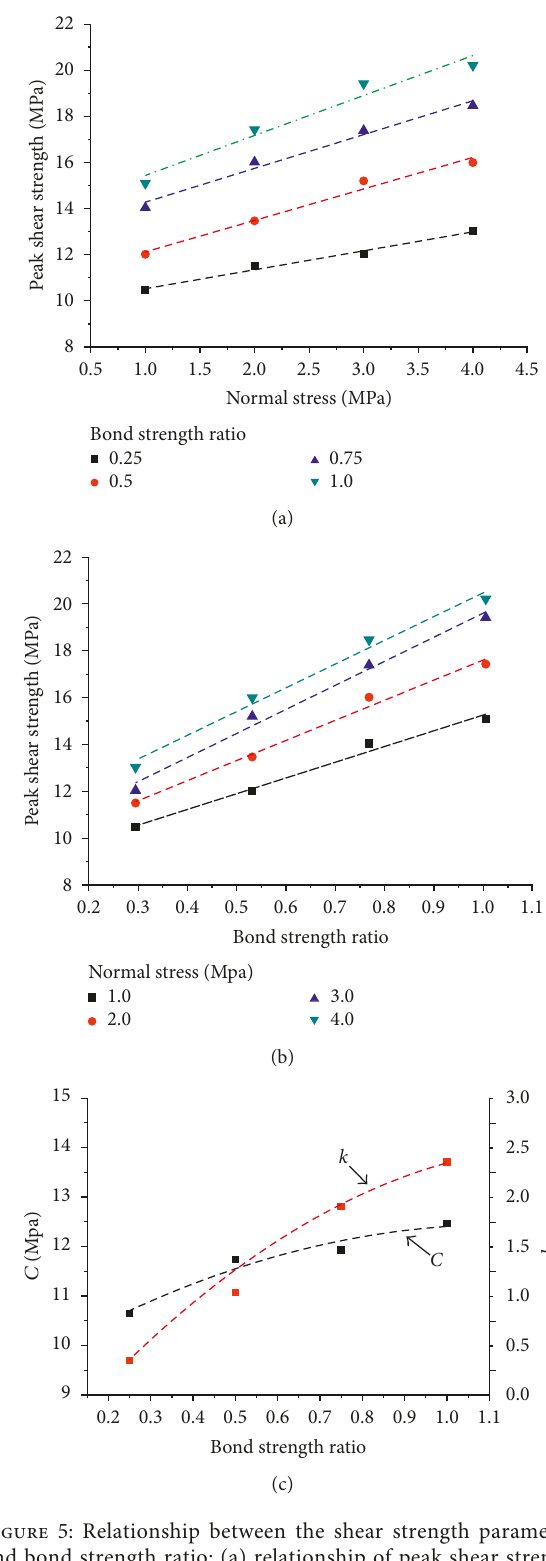
Figure 5: Relationship between the shear strength parameters and bond strength ratio: (a) relationship of peak shear strength and normal stress; (b) relationship of peak shear strength and bond strength ratio; (c) relationship of C and k with bond strength